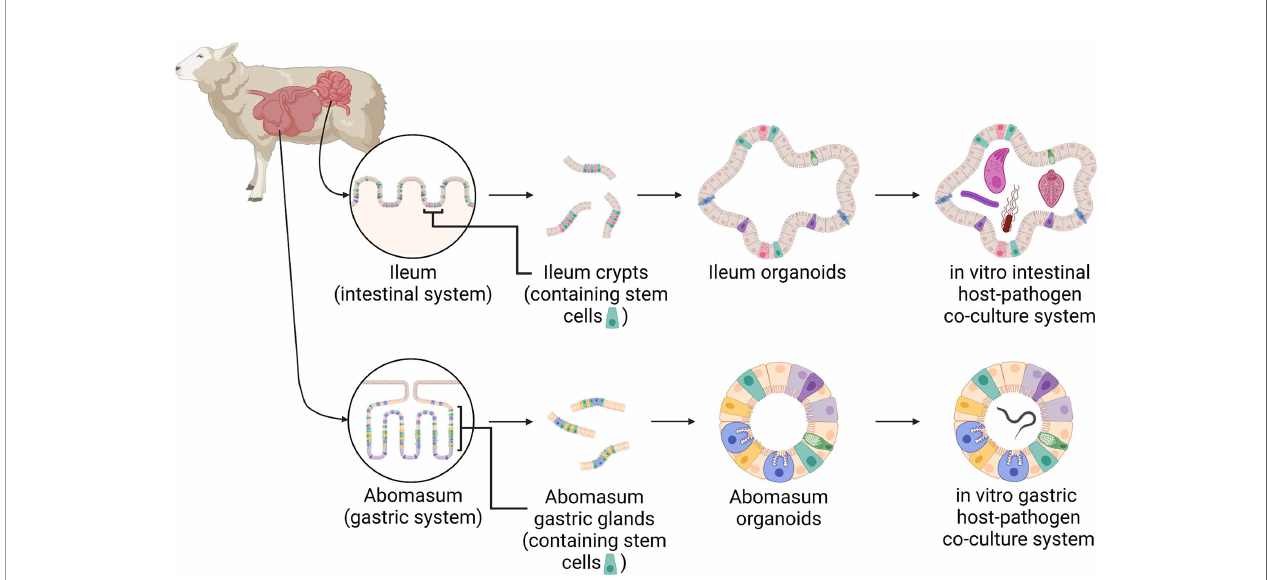
FIGURE 1 | A schematic of the development of ovine gastric and intestinal organoids for studying host-pathogen interactions. Stem cells isolated from sheep ileum crypts and abomasum gastric glands can be cultivated into tissue-speci fi c organoids when grown in a three-dimensional culture system. Gastric and intestinal organoids can be co-cultured with pathogens to model host-parasite interactions in physiologically and biologically-relevant in vitro culture systems. Created with